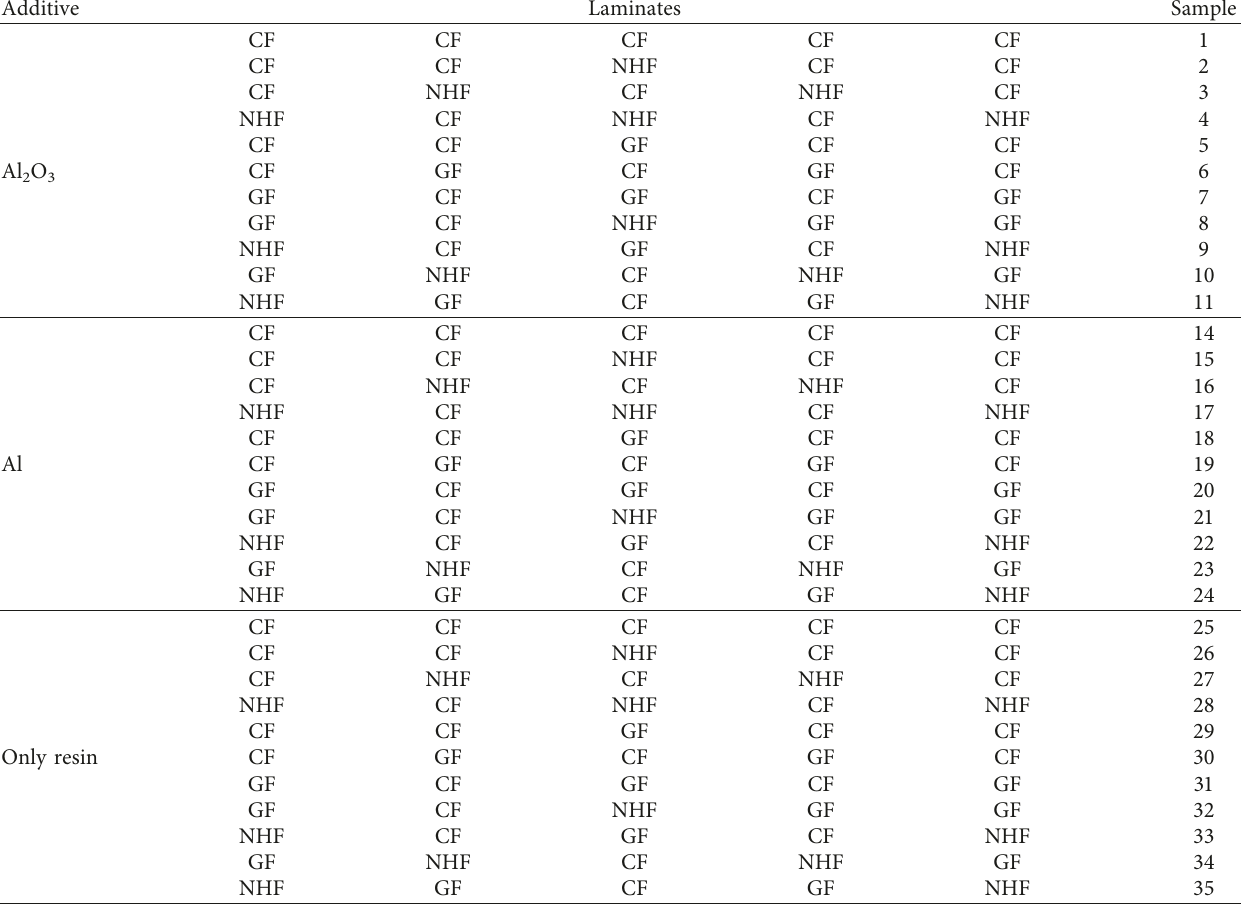
Table 1: Laminate configuration: carbon fiber (CF), glass fiber (GF), and natural henequen fiber (NHF).